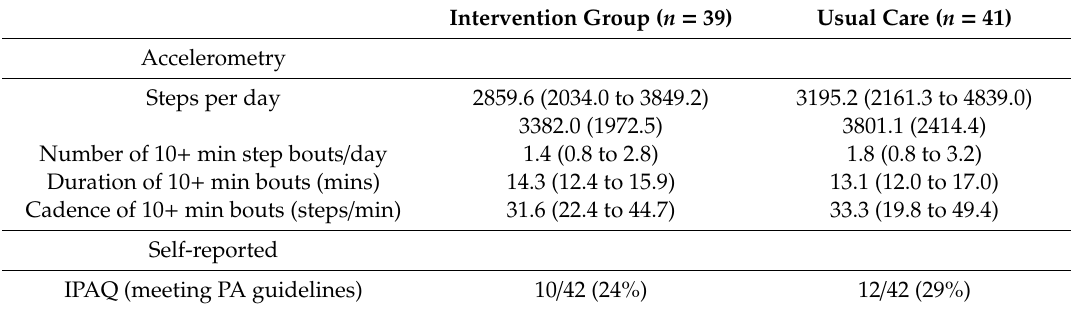
Table 2. Baseline physical activity.